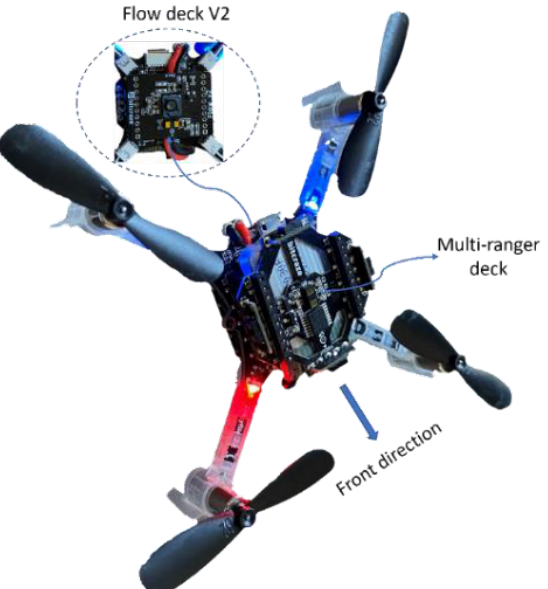
Figure 1 . Bitcraze Crazyflie 2.1 drone with attached Flow deck and multi-ranger deck